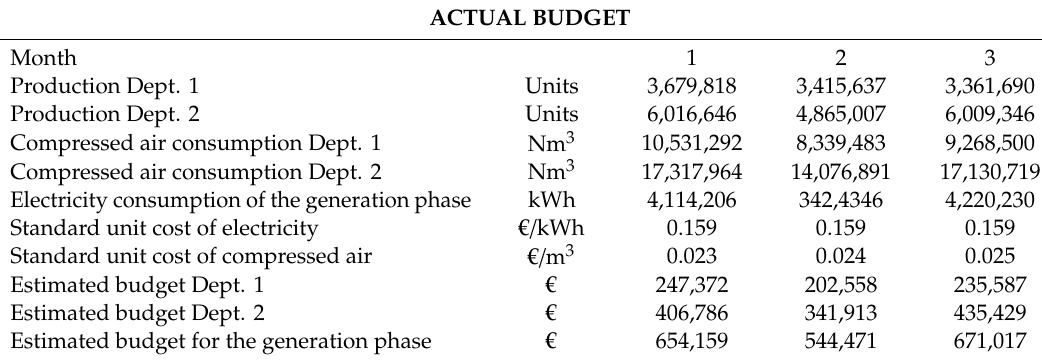
Table 4. Actual compressed air budget for the considered trimester.